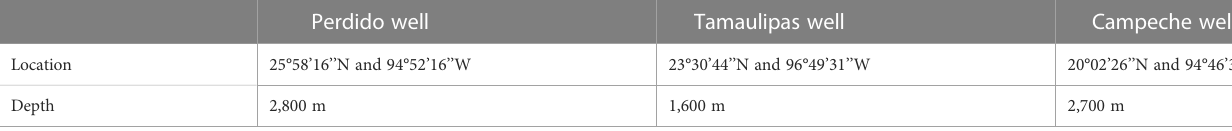
TABLE 2 Location and depth of the three hypothetical wells in the western Gulf of Mexico.